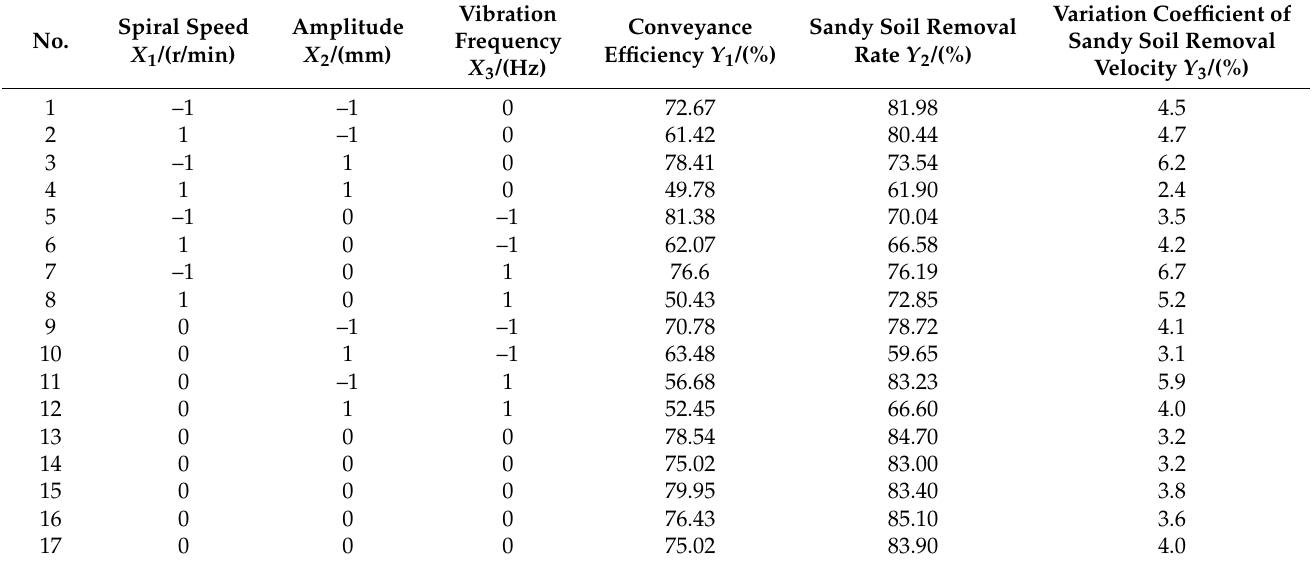
Table 4. Experimental design scheme and